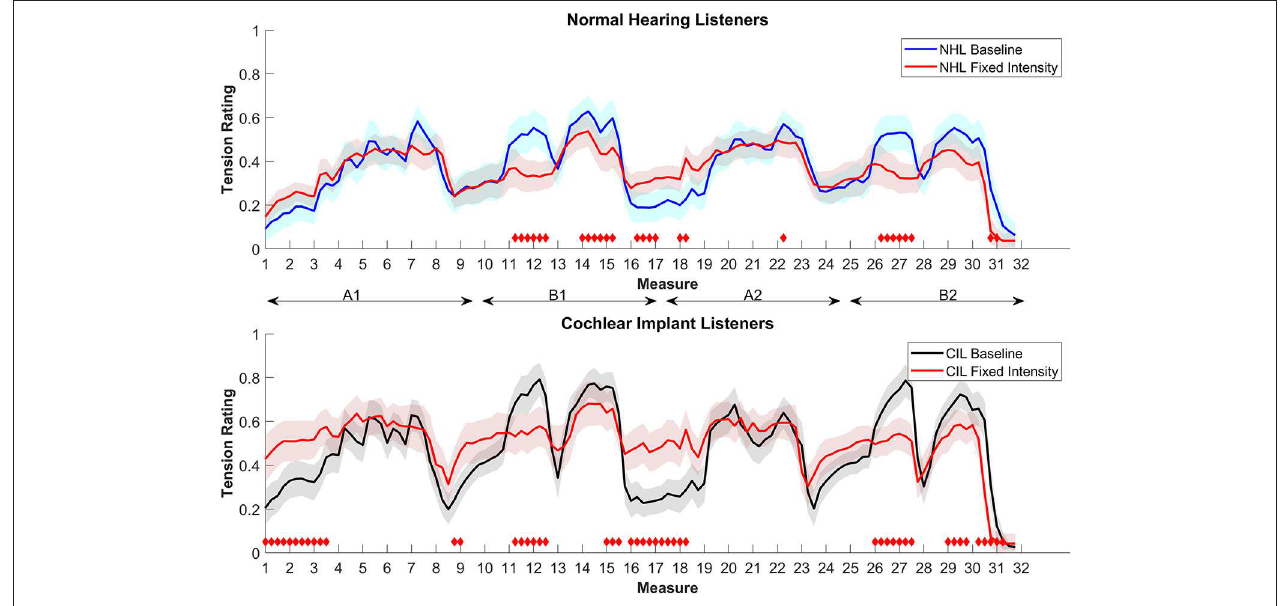
FIGURE 3 | Average tension ratings of 9 NHL (top panel) and 8 CIL (bottom panel) for the baseline and condition 3, fixed intensity (in red). See details in Figure 1 .